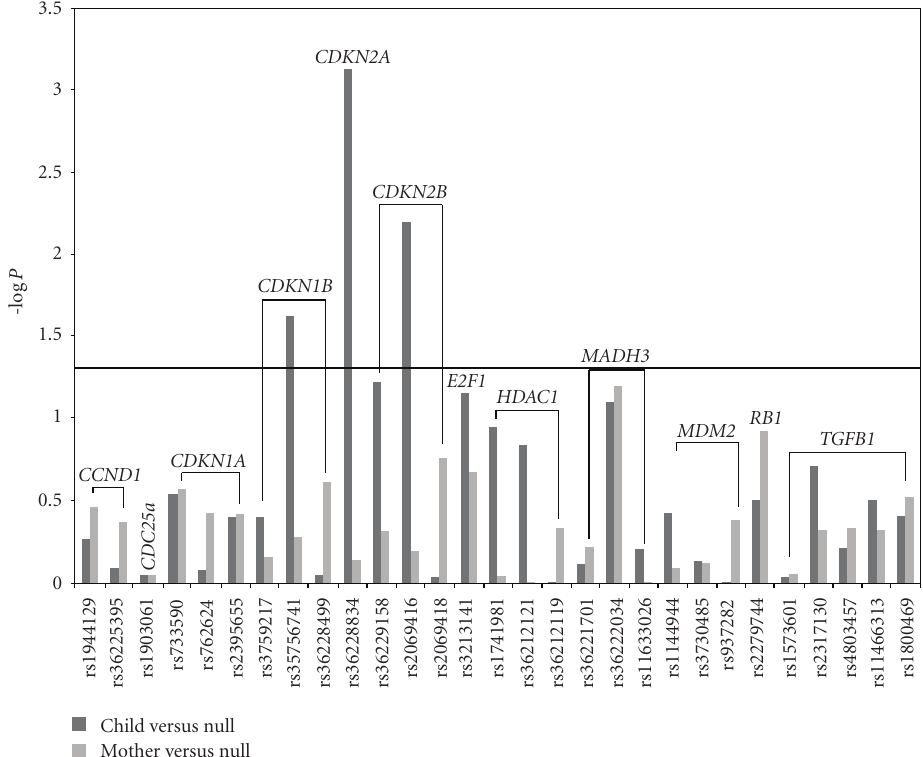
Figure 6: Log-linear, likelihood-ratio association analysis between 29 regulatory SNPs from 12 cell-cycle genes and childhood pre-B acute lymphoblastic leukemia (ALL). Log-linear regression analysis was performed in LEM using 203 case-triads, 118 unrelated ALL patients and 329 controls. Results of the likelihood-ratio chi-square tests ( − log P ) are shown for the single-step Child (blue) and Mother (red) tests. Mating symmetry (i.e., six mating-type parameters) was assumed at all loci but variants rs1144944 and rs3730485 of the MDM2 gene, as well as CDKN2B rs2069416 for which MA models (nine mating-type parameters) were used to test for association. Horizontal reference line indicates P value of .05. Note that for the tri-allelic variant CDKN2B rs2069416 (A > T,C) individuals were grouped according to their T allele such that ∗∗ > ∗ T > TT. See Supplementary Table 1 for complete likelihood-ratio chi-square test